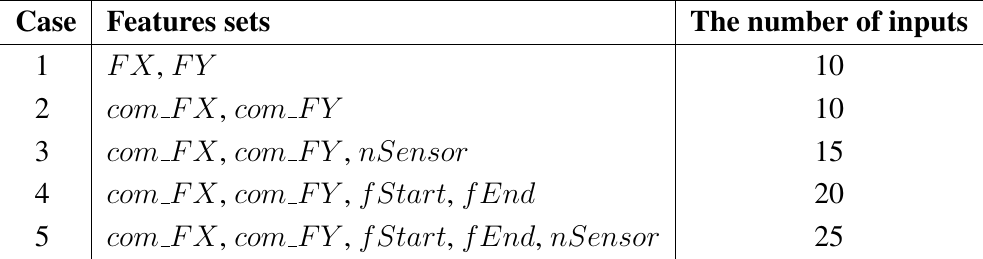
Table 2. Classifications of walking feature